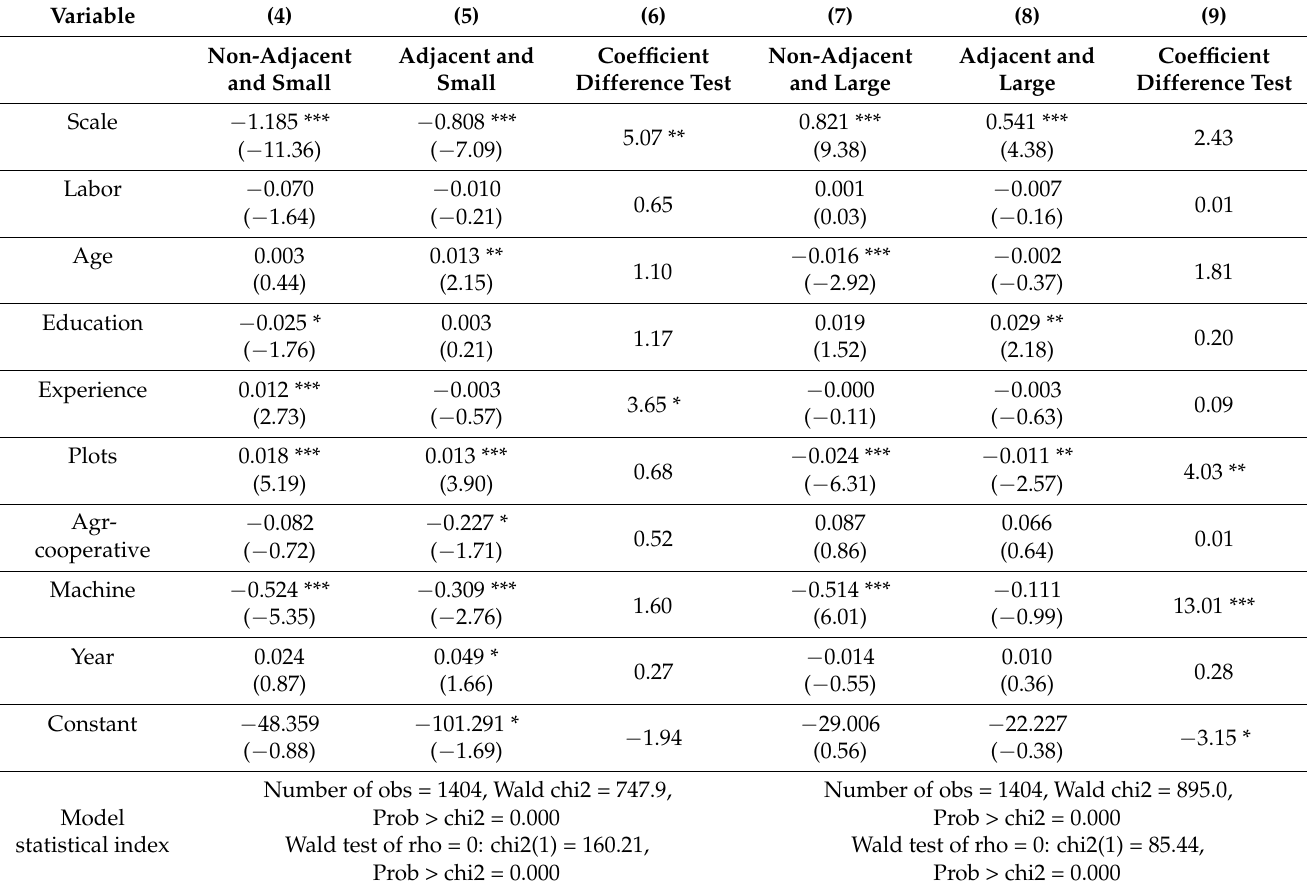
Table 6. Estimated results of the bivariate probit model of the influence of location on plot flow direction with different